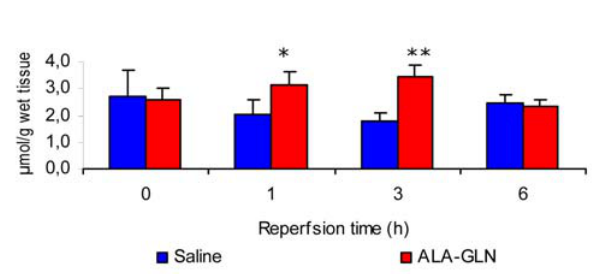
rats.ketone bodies: 1.03±0.11 vs. 0.42±0,05 as compared to those found in non-treated rats. There was also a significant G-1 rats at the end of the reperfusion period (6h)